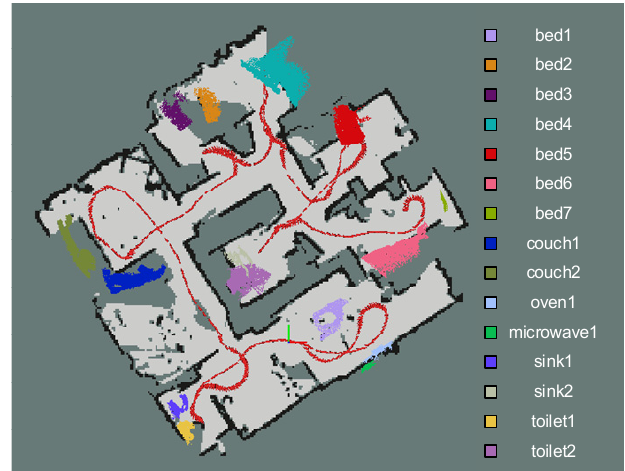
Figure 6. The refinement result of the object point cloud .